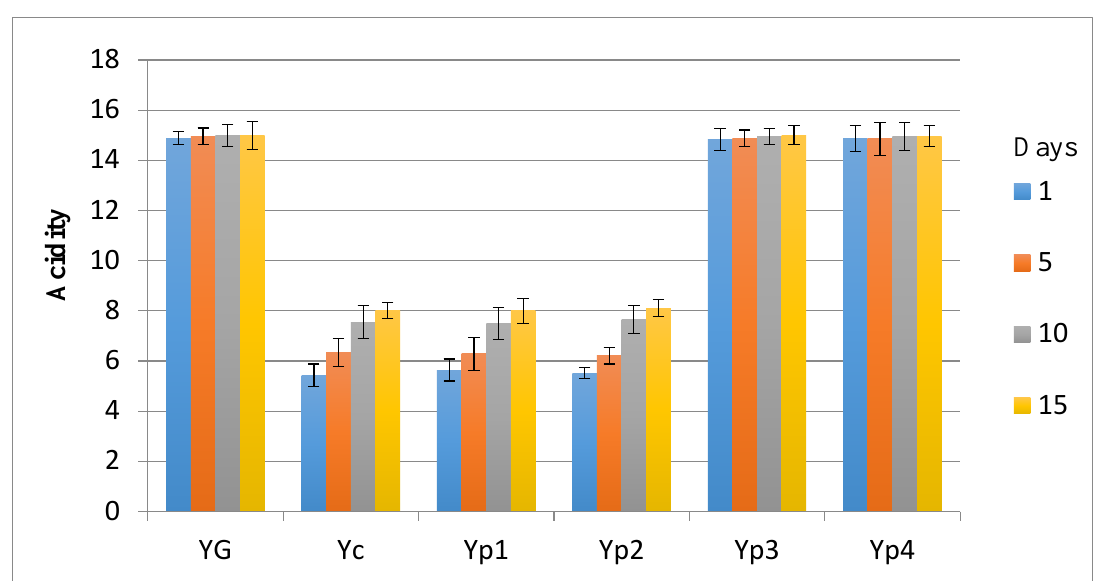
Figure 5. Mean values of yogurt’s flavor during storage.